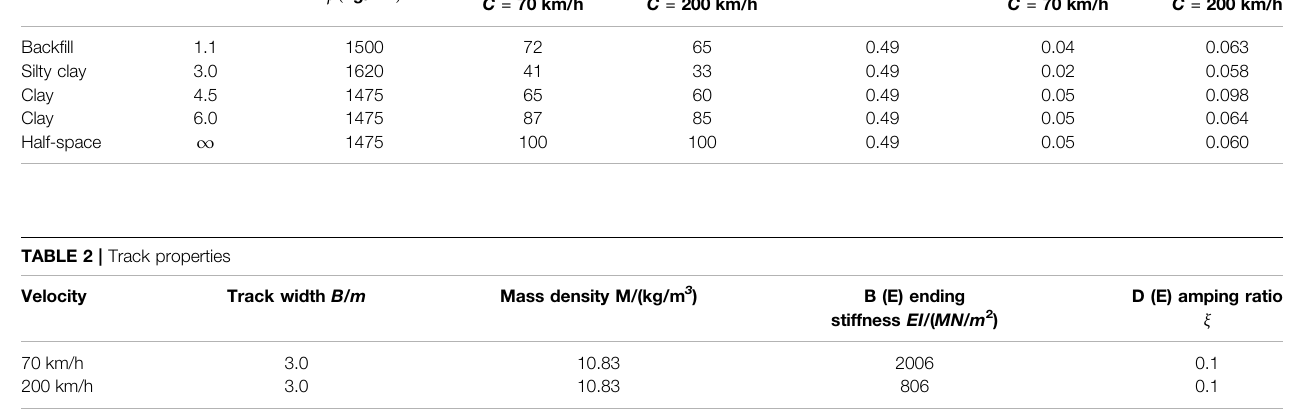
TABLE 1 | Soil parameters under train speeds of 70 and 200 km/h Soil layer